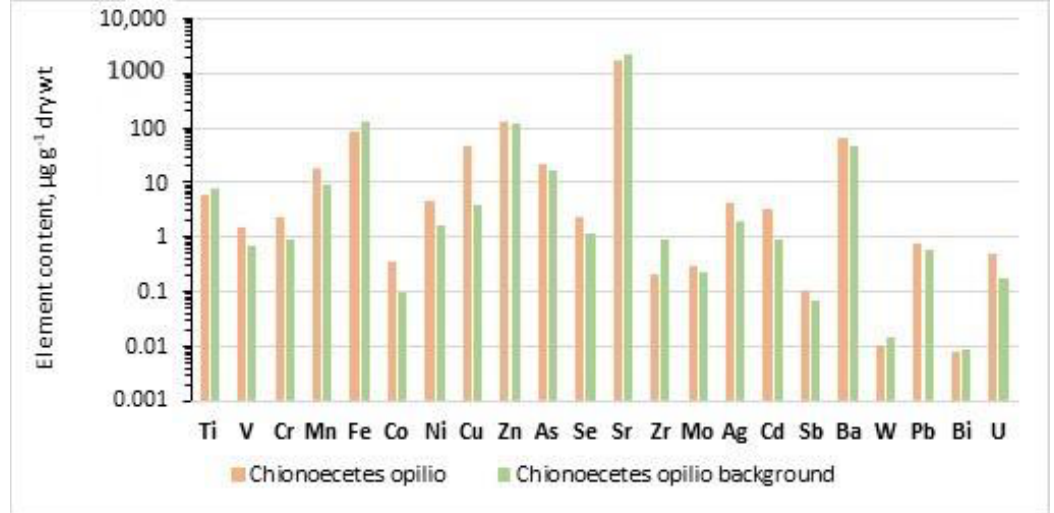
Figure 10. Distribution of elements in Chionoecetes opilio (Crustacea) inhabited zone, affected by hydrothermal fluids at the southern top of the Piip Volcano, and the background zone.